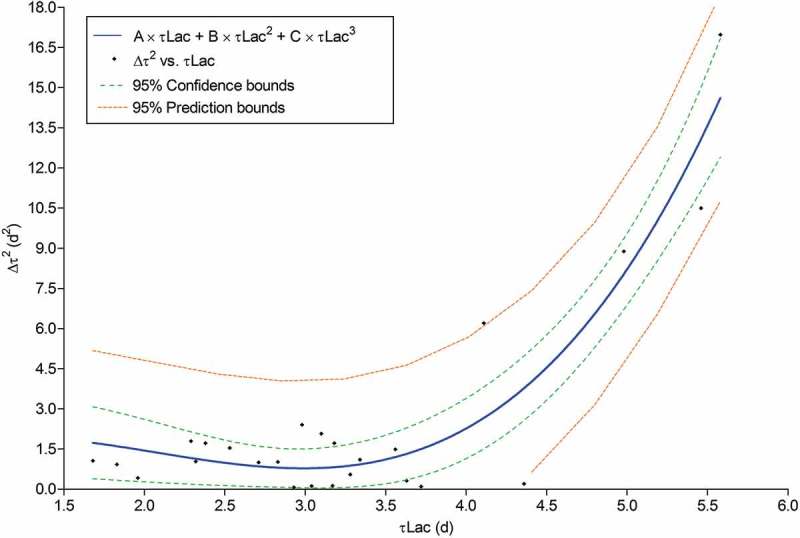
Function and fitted model of Δτ2 with the simple variable τLac.